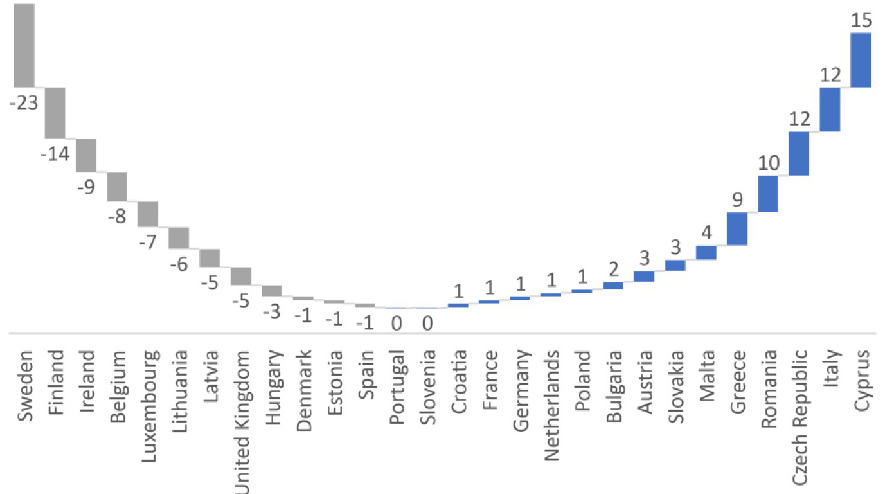
Fig 3. Differences in rankings between the FRA classification and those obtained from the